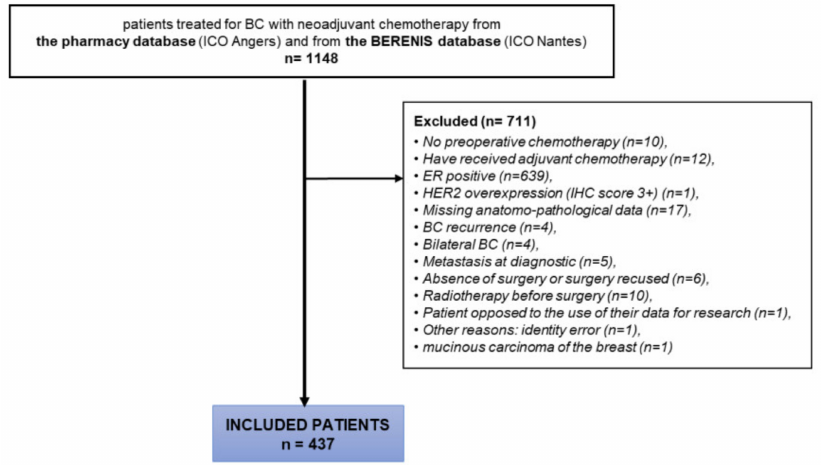
Figure 1. CONSORT diagram of the study. Table 1. Baseline patient